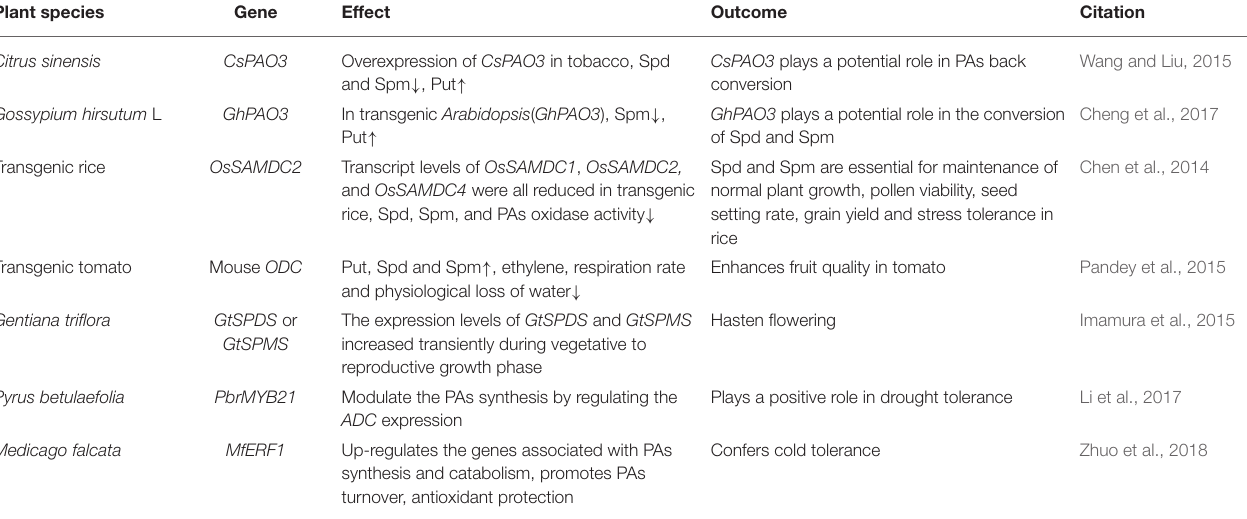
TABLE 2 | Genes related to polyamines on regulating plant growth.